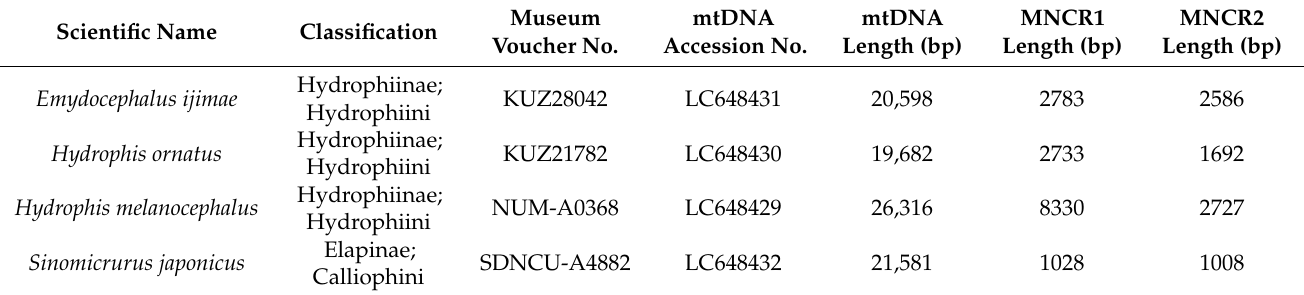
Table 1. Elapid species for which mtDNAs were sequenced in this